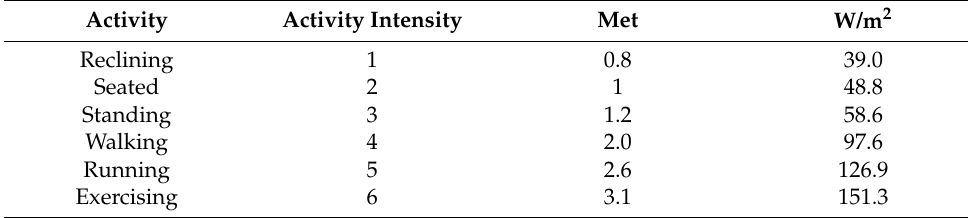
Figure 4. Summer simplified garment checklist. Table 3. Metabolic rate for children with different activity